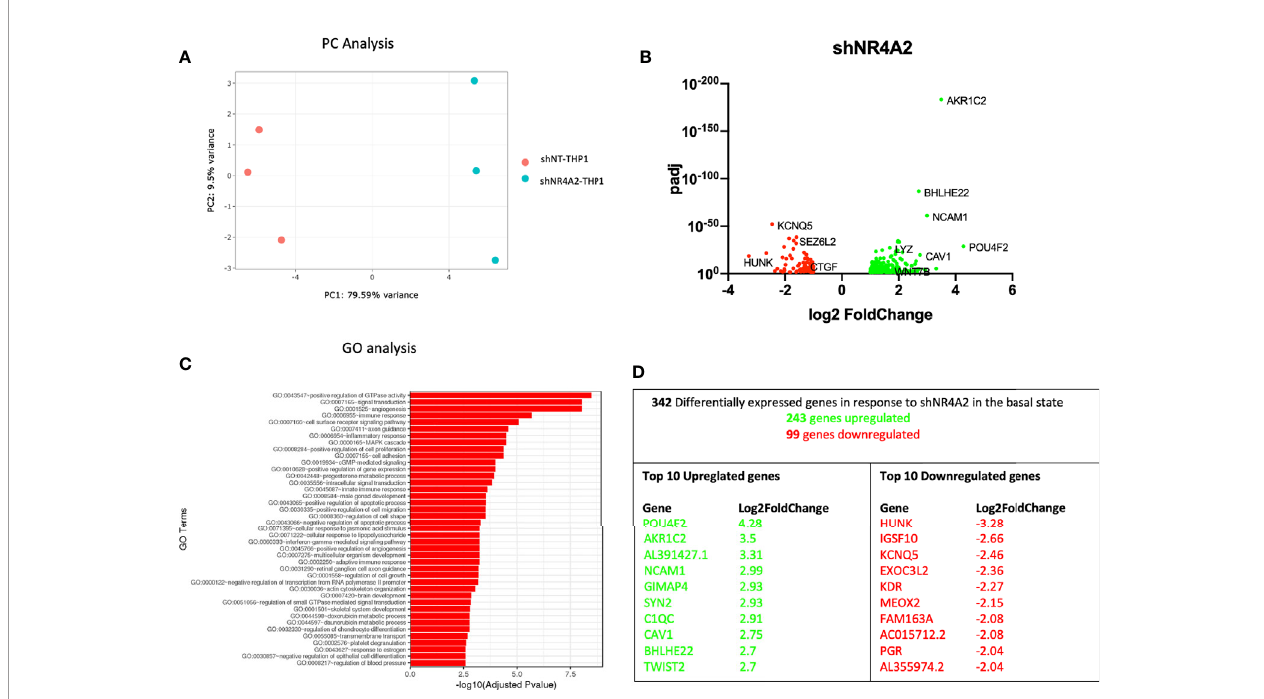
FIGURE 1 | Knockdown of NR4A2 has a distinct transcriptional pro fi le in the basal state. Principal component analysis (PCA) plot of transduced cells based on RNA-seq data between shNT and shNR4A2 cells (A) . Volcano plot of signi fi cant DEGs (p<0.05) upregulated (log2fc>/=1) (green) or downregulated (log2fc</=-1) (red) by knockdown of NR4A2 in THP-1 cells based on RNA-seq data (B) . Top gene ontology (GO) terms associated with knockdown of NR4A2 in THP-1 cells based on RNA-seq data (C) . Summary table of signi fi cant DEGs upregulated (green) and downregulated (red) by knockdown of NR4A2 in THP-1 cells based on RNA-seq data (D)